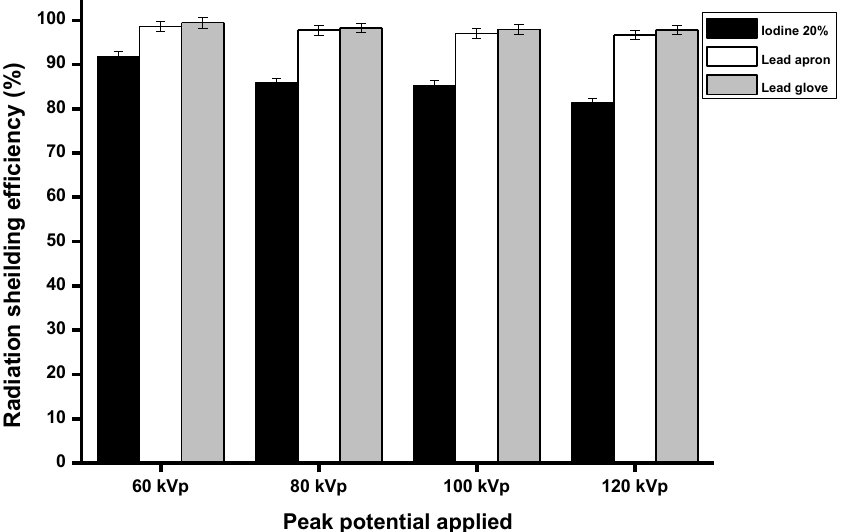
Figure 4. The radiation absorption at 60, 80, 100, and 120 kVp.